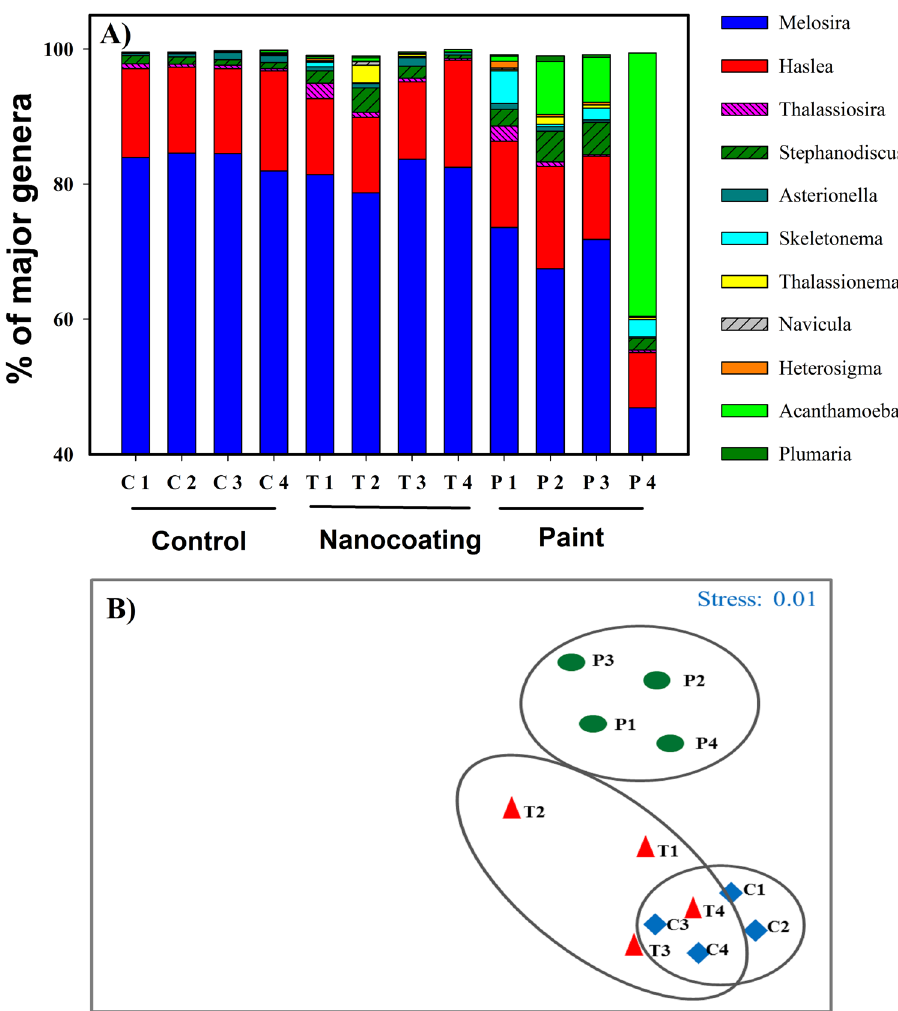
Figure 5. Community compositions of major fouling eukaryotes and cluster analysis. ( A ) Stacked bar chart showing the relative abundance (%) of major eukaryotic genera present on the control ( C ), nanocoated (T) and AF painted (P) net substrates during exposure in marina. 1–4 represents samples collected on weeks 1 to 4. Reported values represent average value obtained from three replicates. Eukaryotic genera contributing < 1% are not shown. B) MDS plot showing the clustering of major eukaryotic genera present on the control ( C ), nanocoated (T) and AF painted (P) net substrates during one month exposure in marina. 1–4 represents samples collected on weeks 1 to